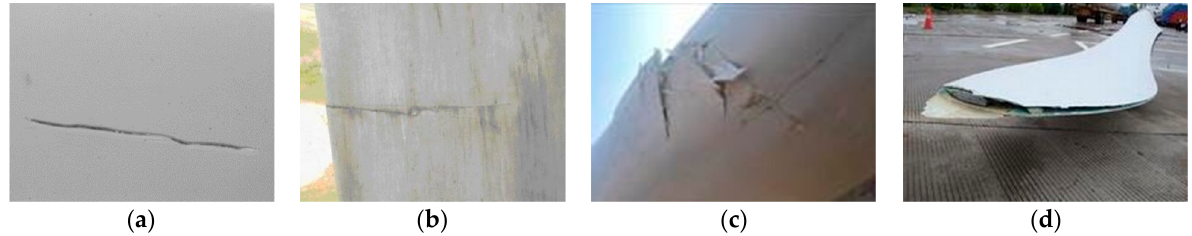
Figure 1. Typical images of defects: ( a ) scratch; ( b ) crack; ( c ) excoriation; ( d ) a blade cracked by lightning.